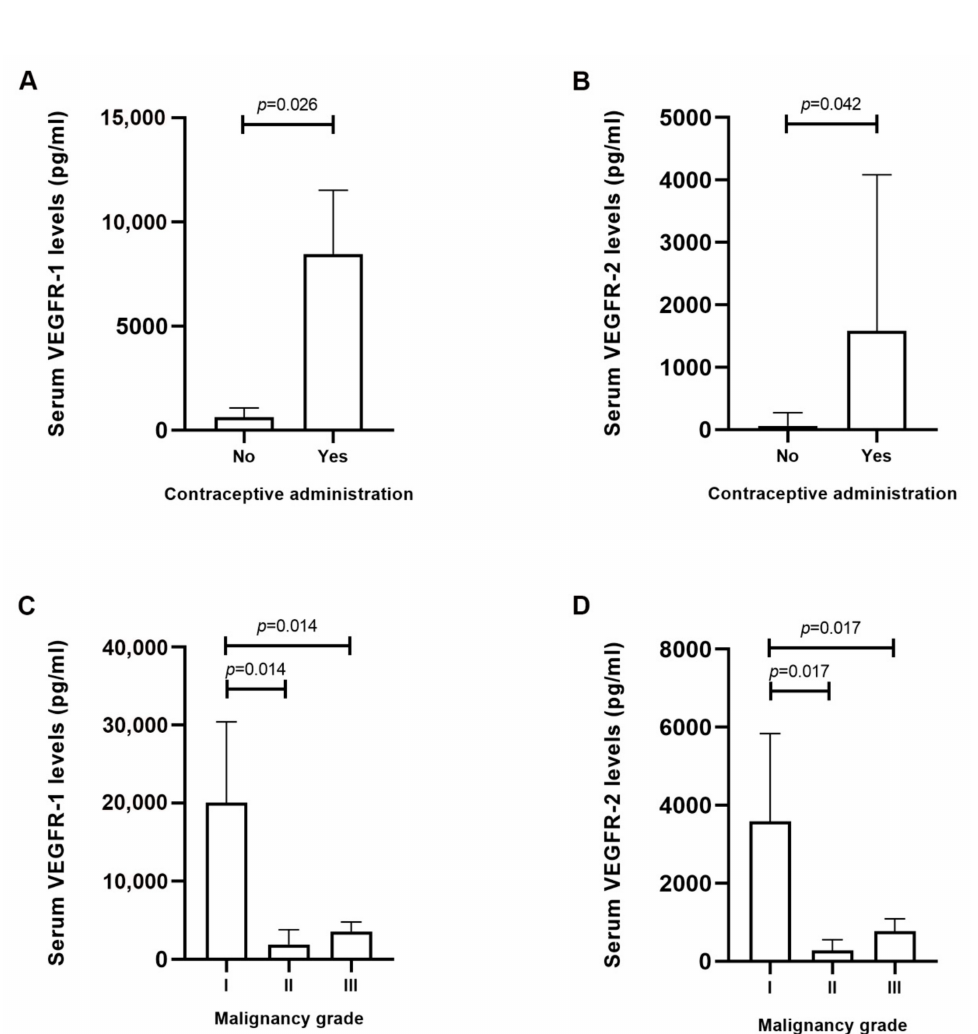
Figure 2. Serum levels of vascular endothelial growth factor receptor 1 (VEGFR-1) and receptor 2 (VEGFR-2) are positively correlated with the use of contraceptives and lower-malignancy tumors. ( A , B ) Box-plot analysis showing the mean ± SEM of serum VEGFR-1 and VEGFR-2 levels and its correlation with the use of contraceptive drugs and ( C , D ) tumor malignancy